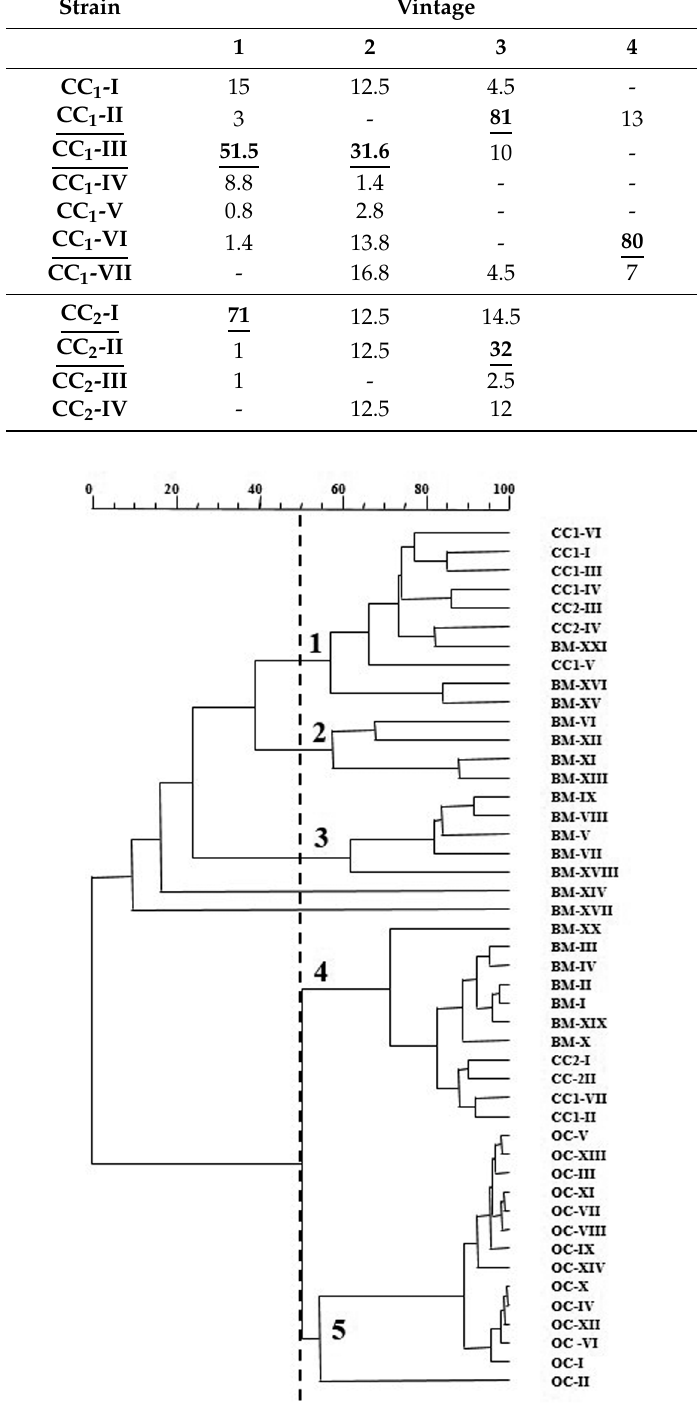
Figure 2. Dendrogram from UPGMA clustering analysis, based on the Dice coe ffi cient of mt-DNA Rsa I restriction patterns of the S. cerevisiae strains recurring in spontaneous wine fermentations carried out in four di ff erent wineries (BM, OC, CC1 and cc2) in Tuscany (Italy). Arabic numerals at 50% similarity indicate the di ff erent